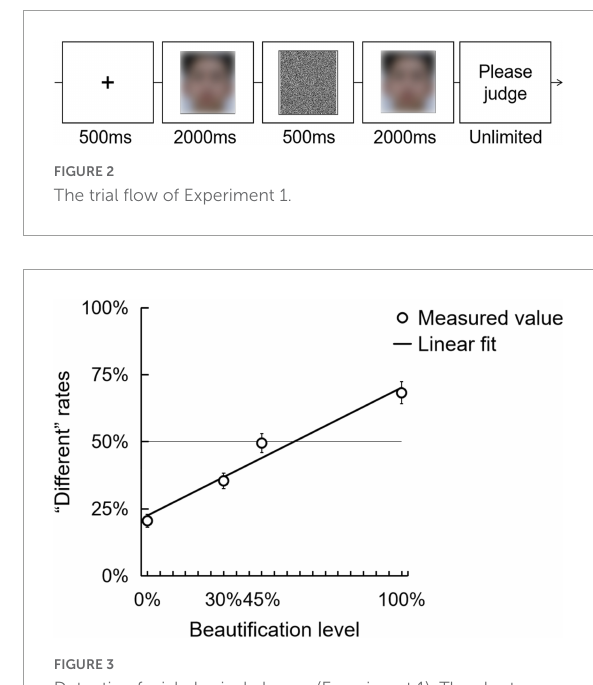
FIGURE3 Detecting facial physical change (Experiment 1). The chart shows the “different” rates and standard errors for each beautification level. The oblique line represents the fitted linear